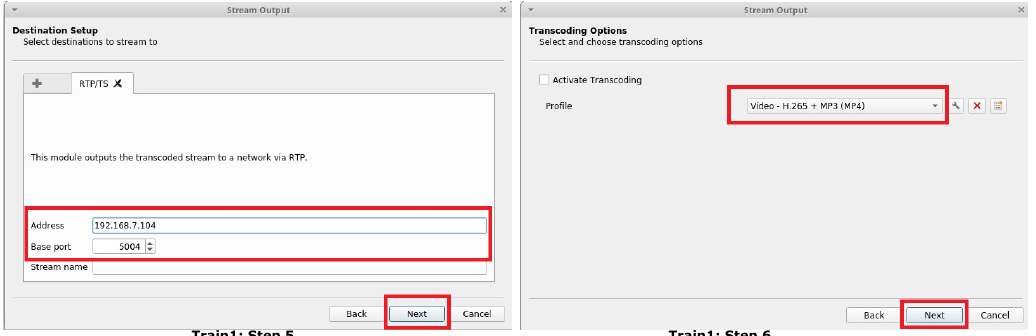
Figure 35. Train1: adding the destination IP address of RailServer.